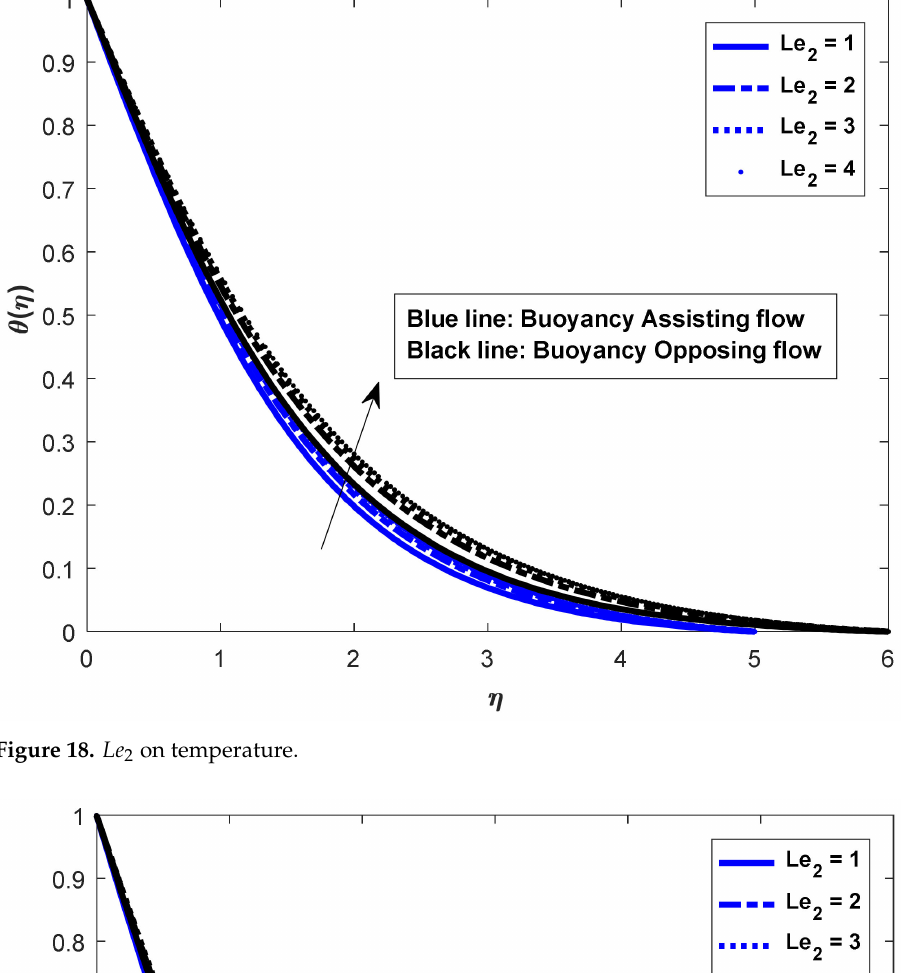
Figure 18. Le 2 on temperature.